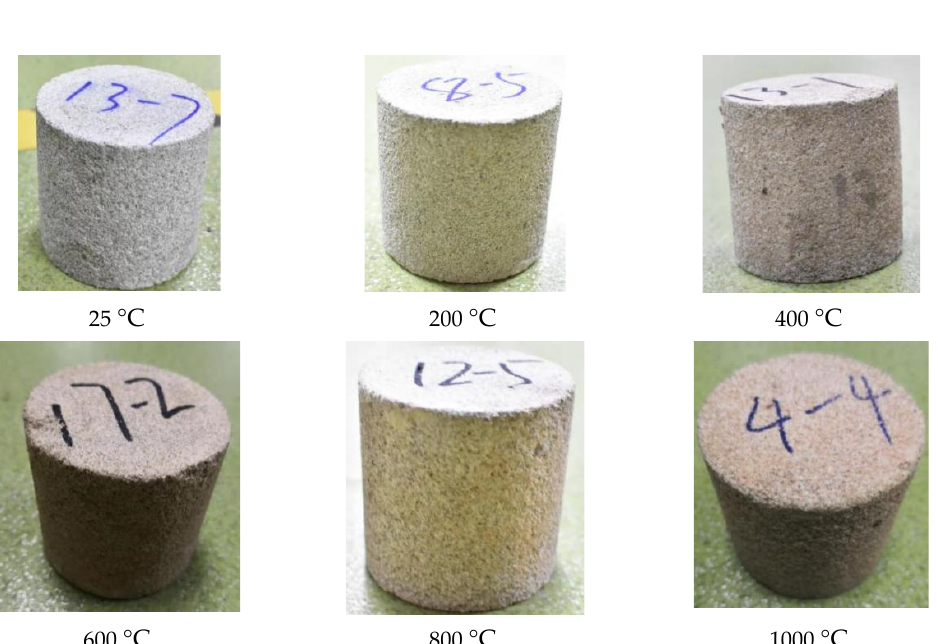
Figure 3. Muffle furnace.